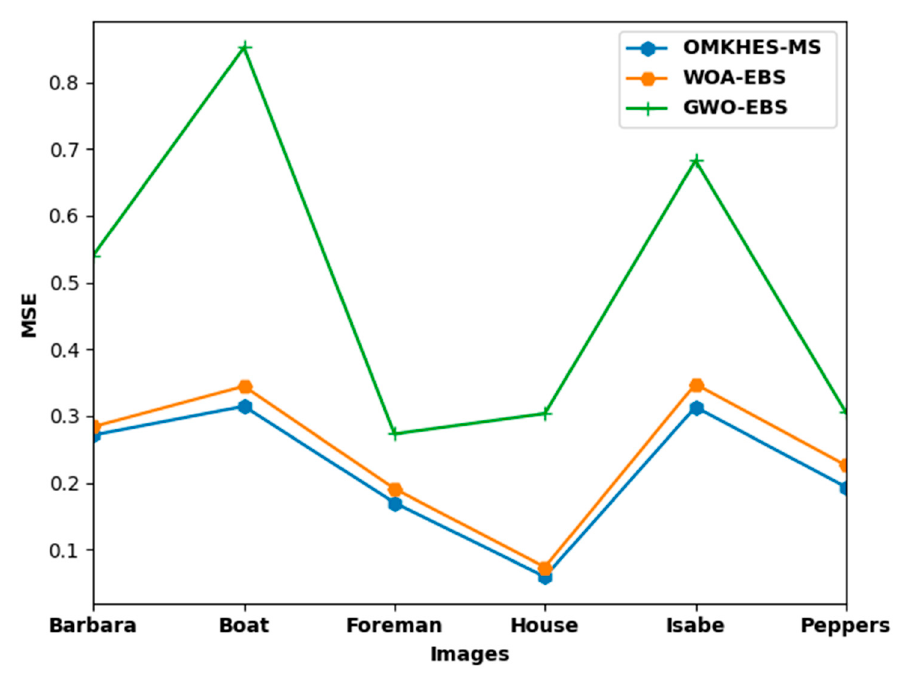
Figure 6. Comparative MSE analysis of OMKHES-MS technique with existing models. Figure 7 exemplifies the RMSE examination of the OMKHES-MS model with existing models on diverse images. The experimental values reported that the OMKHES-MS model has resulted in improved performance with lower values of RMSE over the other WOA-EBS and GWO-EBS models. For instance, with Barbara image, the OMKHES-MS model has attained decreased RMSE of 0.5211 whereas the WOA-EBS and GWO-EBS